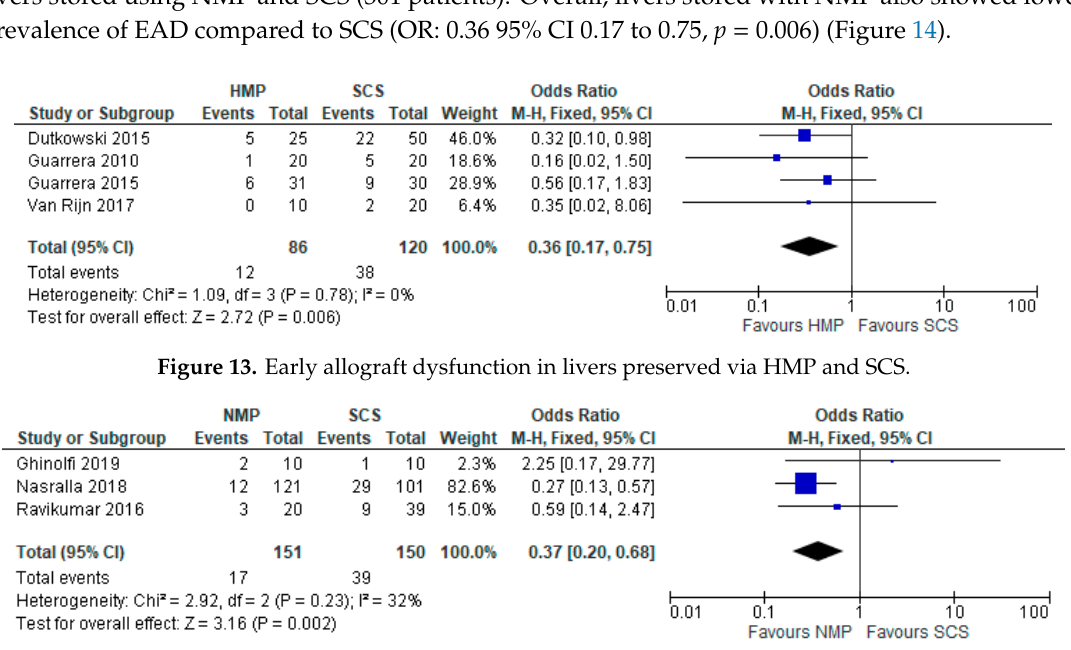
Figure 14. Early allograft dysfunction in livers preserved via NMP and SCS.